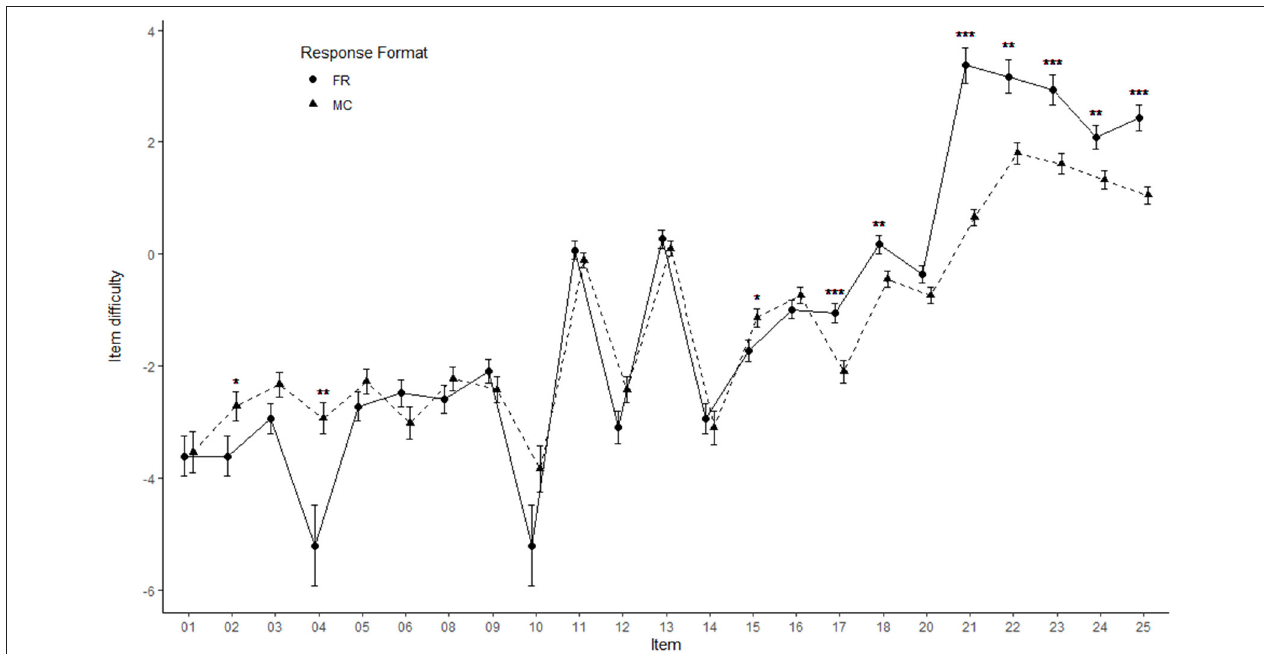
FIGURE 3 | Comparison of item difficulties between FR and MC format. Error bars represent 95% confidence intervals. * p < 0.05. ** p < 0.01. *** p <